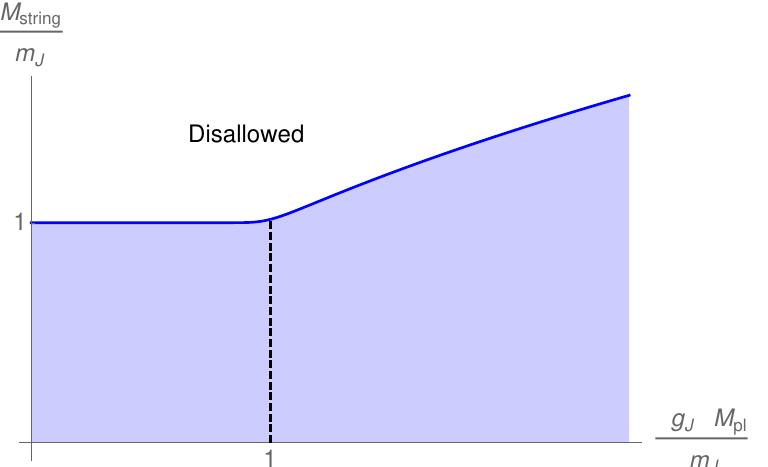
A schematic exclusion plot for the string scale M the unshaded region, HS theories violate causality. The solid blue line represents the bound (1.3) for J = 3 . For J > 3 , the bound asymptotes to 1 at a faster rate. The weak gravity condition is satisfied in the right of the dashed black